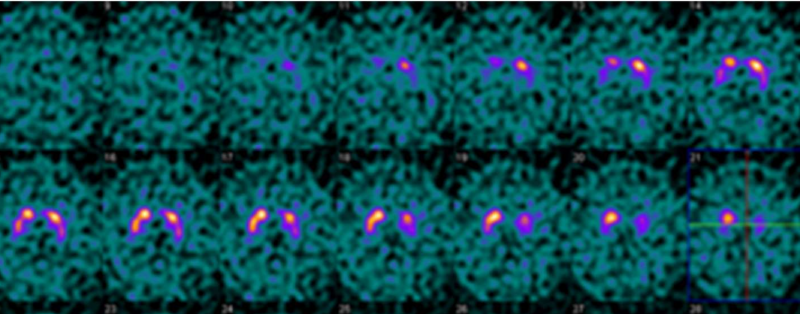
Figure 3. Example DaTQUANT results in a non-PS patient demonstrating asymmetric loss of uptake within the left posterior putamen. Despite the asymmetry, none of the summary measures, SBR (1.39), z-score ( − 0.31), or percent deviations ( − 0.07) meet the threshold for abnormal.